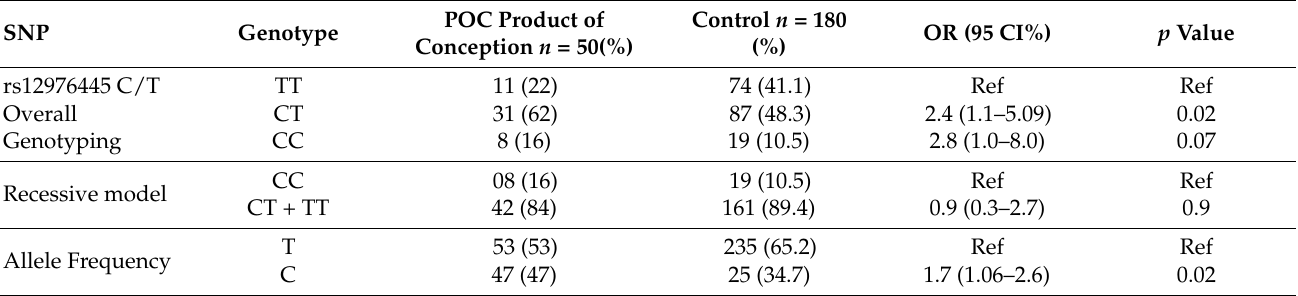
Table 2. Single nucleotide polymorphism (SNP) genotype distribution and allele frequencies